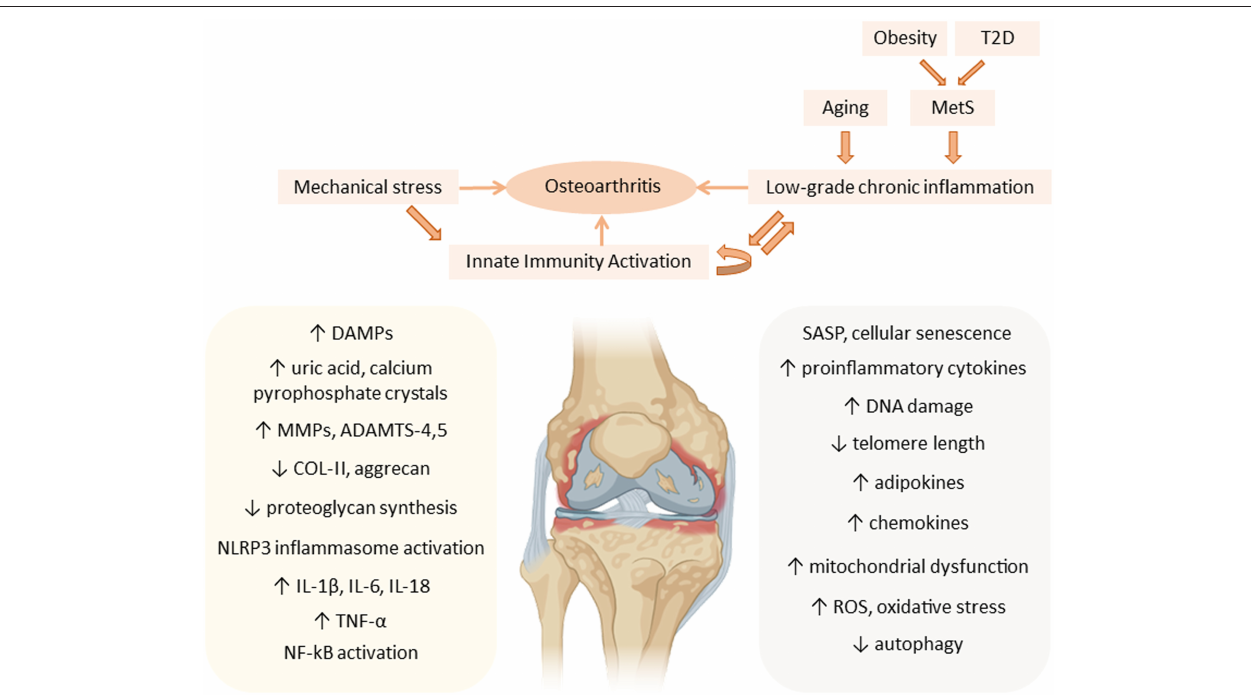
FIGURE 2 | Metainflammation in the pathogenesis of osteoarthritis (OA). Mechanical stress contributes, together with the low-grade chronic inflammation associated with aging and the components of the metabolic syndrome (MetS), to the chronic activation of innate immunity in the joint, mainly affecting articular cartilage, during OA progression. Aging-associated factors and senescence together with metabolic factors, such as an increase in adipokines, maintain a systemic low-grade chronic inflammatory status that contributes to the pathogenesis of OA, increasing the expression of cartilage catabolic enzymes (MMPs, ADAMTS), and pro-inflammatory cytokines (IL-1 β , IL-6, IL-18, and TNF- α ), thus perpetuating inflammation in the joint. ADAMTS, a disintegrin and metalloproteinase with thrombospondin motifs; COL-II, type II collagen; DAMPs, danger-associated molecular patterns; DNA, deoxyribonucleic acid; IL, interleukin; MMP, matrix metalloproteinases; MetS, metabolic syndrome; NF-kB, nuclear factor kappa B; NLRP3, NOD-, LRR- and pyrin domain-containing protein 3; ROS, reactive oxygen species; SASP, senescence-associated secretory phenotype; T2D, type 2 diabetes; TNF, tumor necrosis